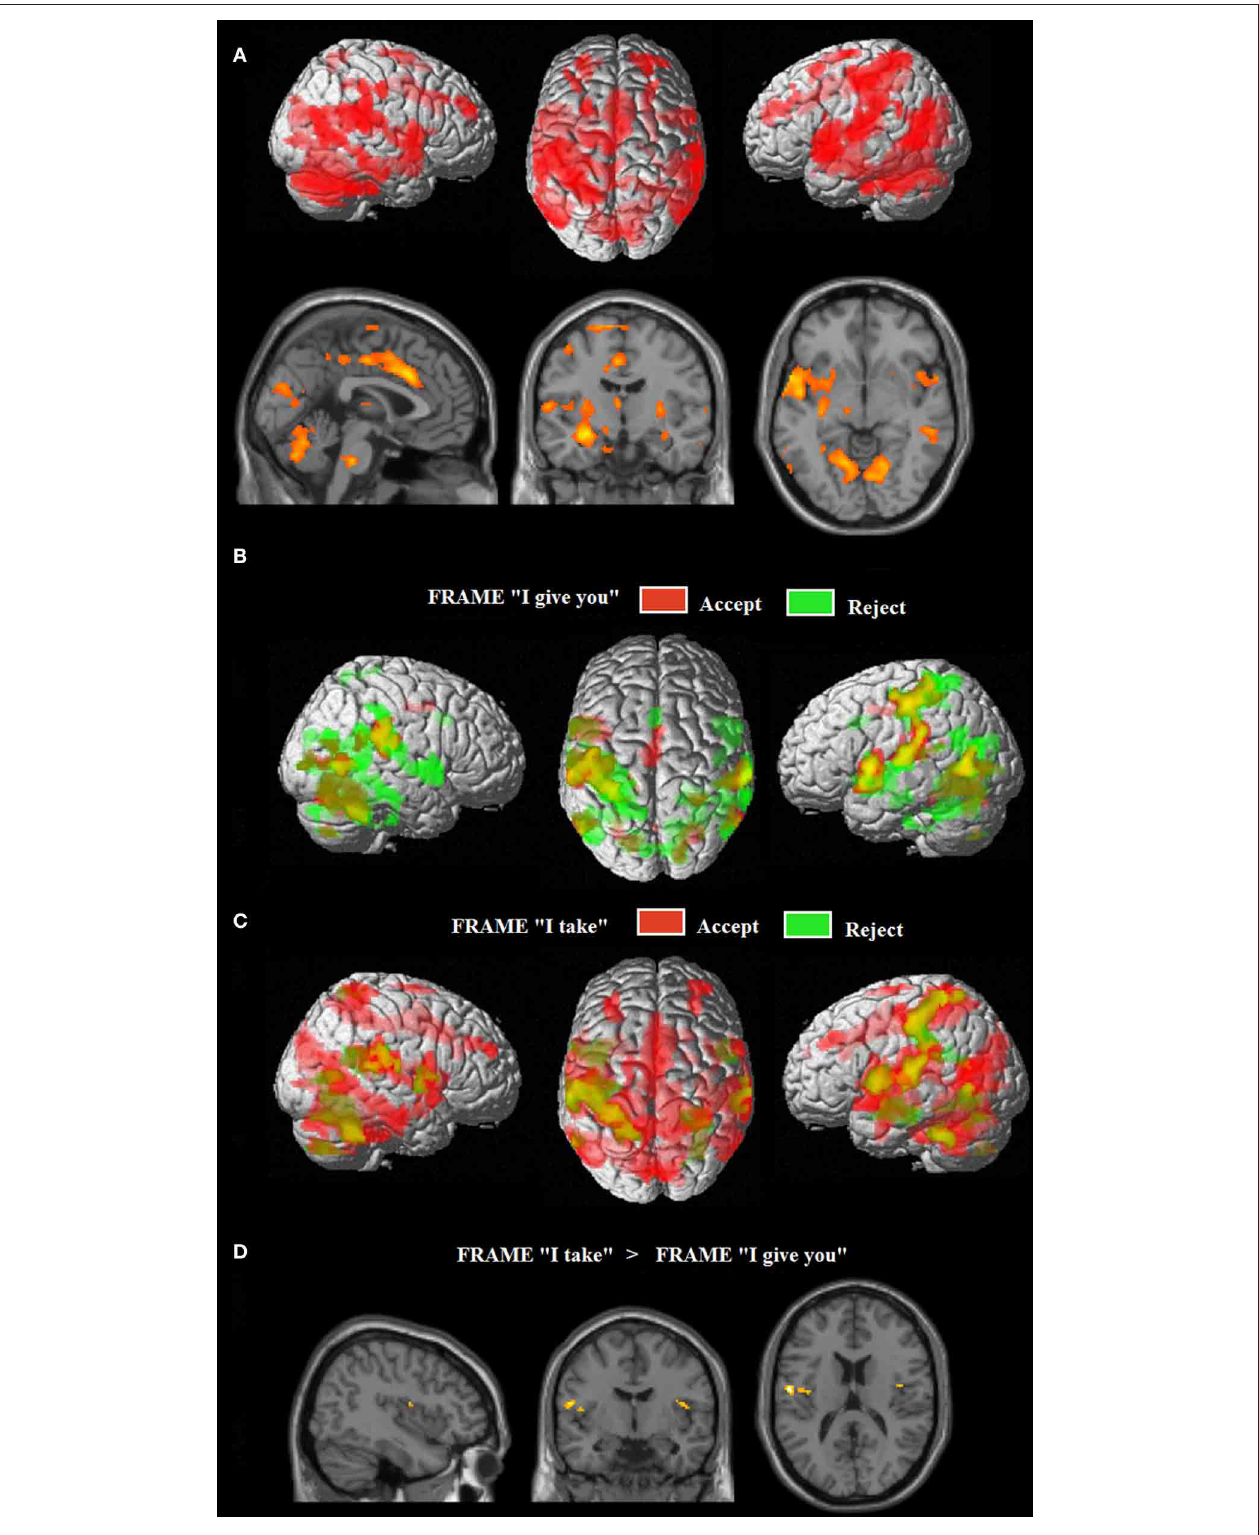
FIGURE 2 | (A) Common neural networks associated with the UG task; network of areas differentially recruited by response “reject” in green (relative to “accept,” in red) for frame “I give you” (B) and for frame “I take” (C) . Activations are displayed on a